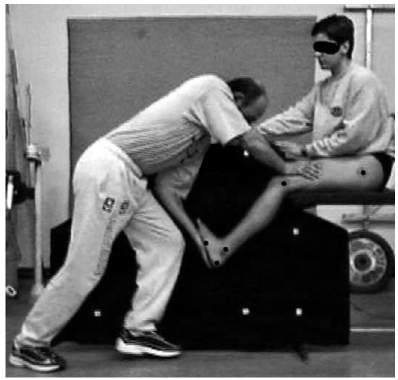
Figure 1. The procedure for the ankle range of motion measurement. After the placement of the markers, the participants sat, with their torso in an upright position, on an examination bed. The knee joint was at the edge of the bed,